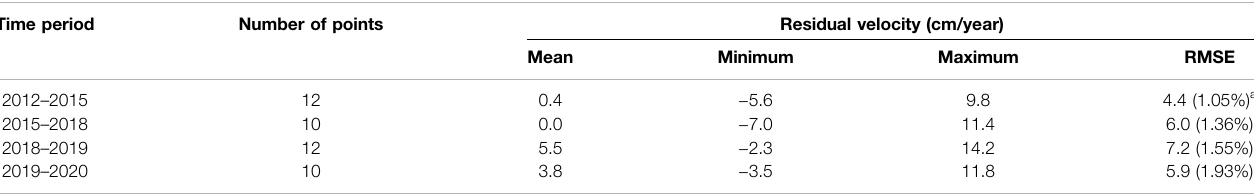
RMSE, Root-mean-square error. a Percentage of maximum fl ow velocity.